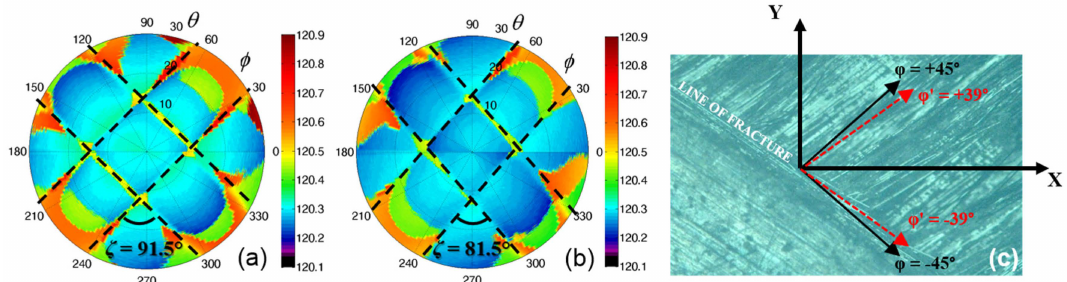
Figure 9. P-UPS images of [ ´ 45 ˝ ,+45 ˝ ] S C/E laminate: before ( a ) and after ( b ) applying the shear load. Microscopic image of the fracture area when shear loading a [ ´ 45 ˝ ,+45 ˝ ] S C/E laminate until failure ( c